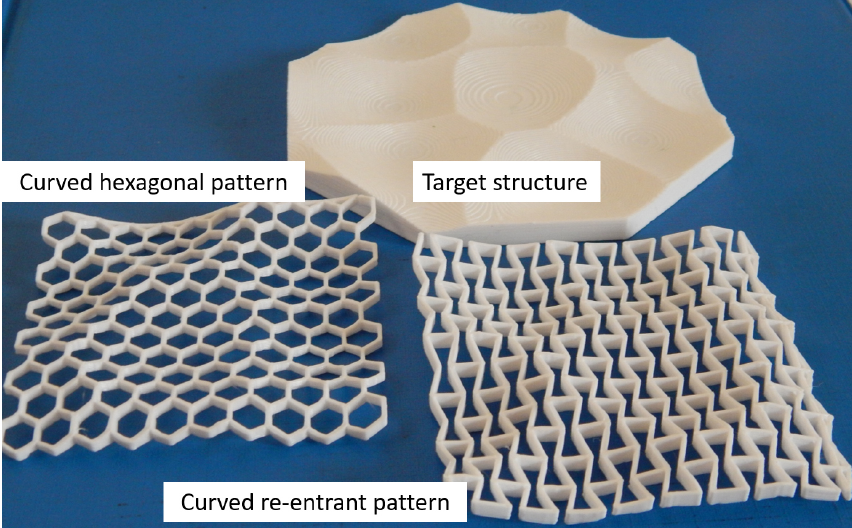
Figure 19. Curved lattices printed by the projection of printing